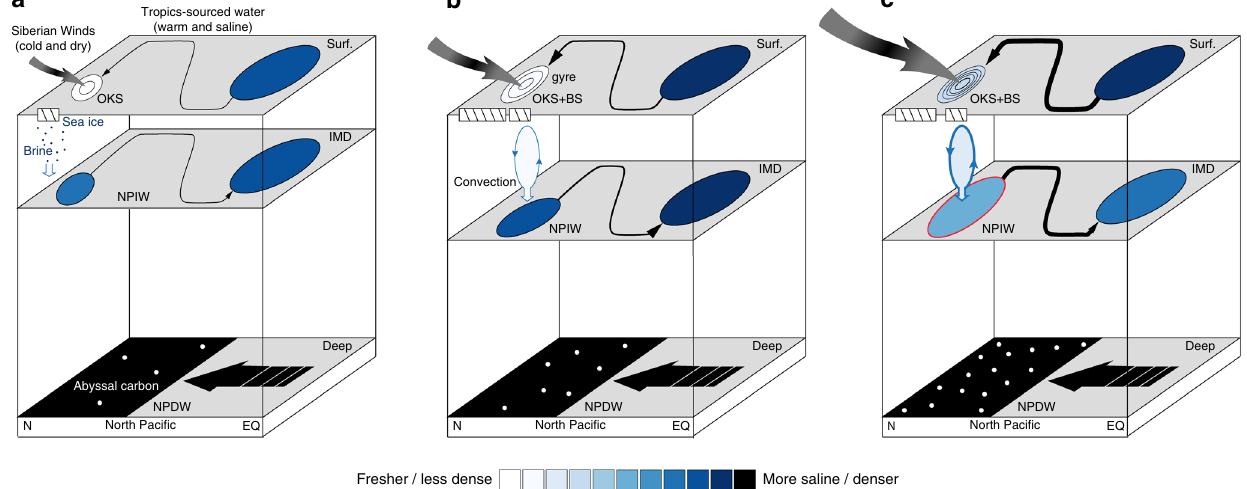
Fig. 5 Schematic illustration of the mechanism proposed in this study and its implication for the reservation of North Paci fi c deep-ocean carbon. a The Modern; b LGM and c HS-1. OKS and BS mean the Sea of Okhotsk and Bering Sea, respectively. The white-bluish-black colours indicate an increase in salinities and also densities. In the subarctic Paci fi c region, denser circles indicate a stronger gyre circulation. In c , the red circle of the NPIW water indicates relatively warmer conditions during HS-1 compared to the LGM